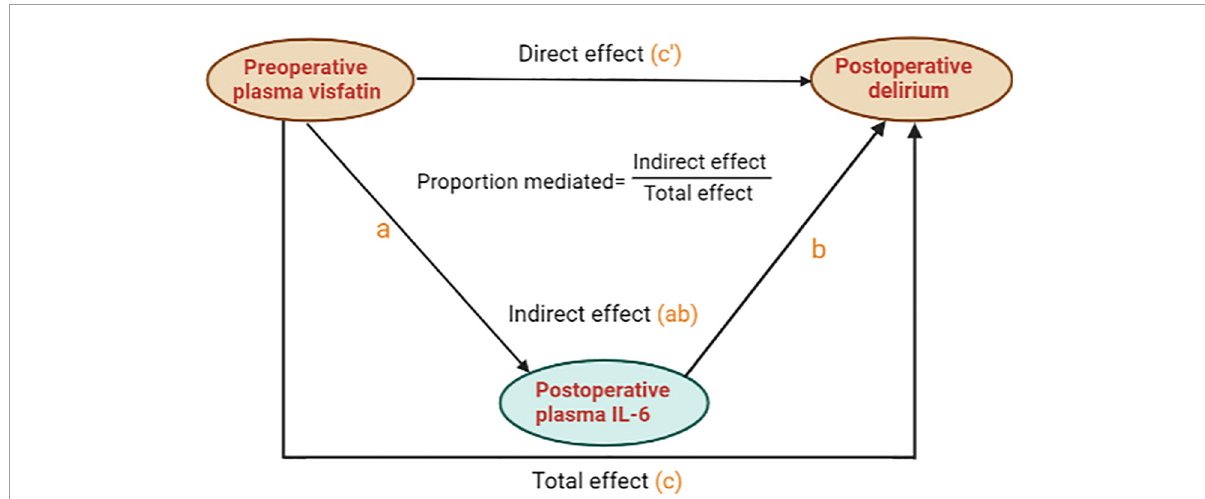
FIGURE4 A mediation analysis model diagram. For brevity and clarity, a simplified version of the calculated model is presented. “c” means the total effect of preoperative plasma visfatin on postoperative delirium (POD) is represented by “c”, whereas, “c”’ means the direct effect of preoperative plasma visfatin on POD after controlling for the level of postoperative plasma interleukin (IL-6); “a” means the effect of preoperative plasma visfatin on the level of postoperative plasma IL-6; “b” means the effect of postoperative plasma IL-6 on POD, after controlling for preoperative plasma visfatin, the indirect effect of preoperative plasma visfatin on POD through postoperative plasma IL-6 can then be quantified as the product of “a” and “b”. IL-6, interleukin-6; POD, postoperative